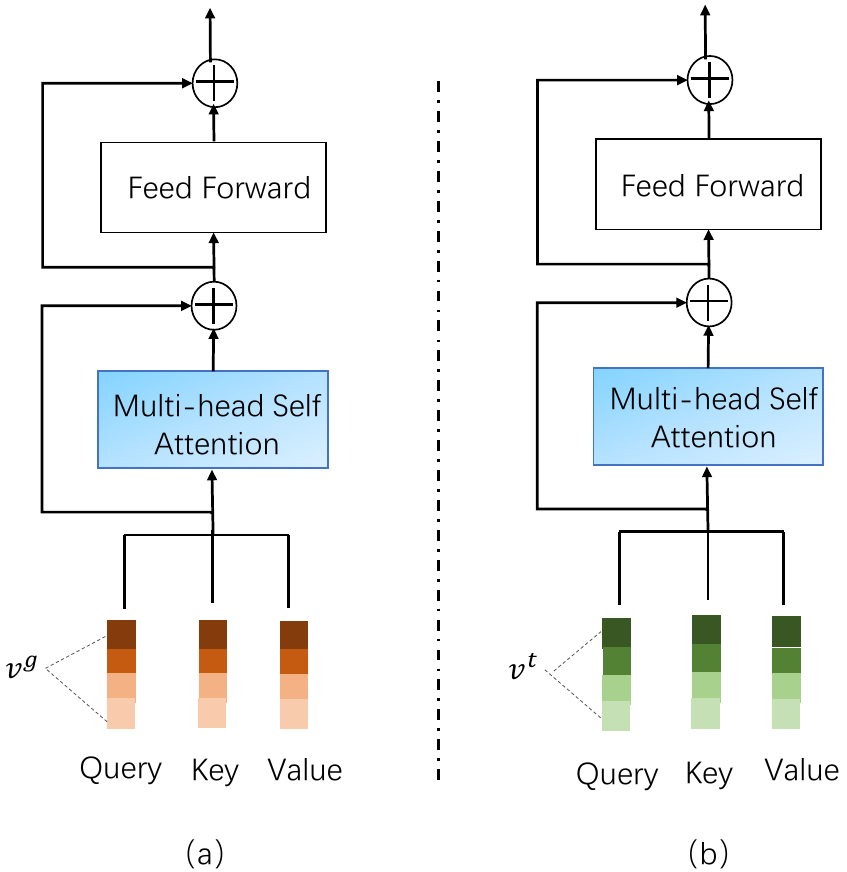
Figure 2. Illustration of the Feature Learning Layer. ( a ) Represents the Image Feature Learning Layer and ( b ) represents the Text Feature Learning